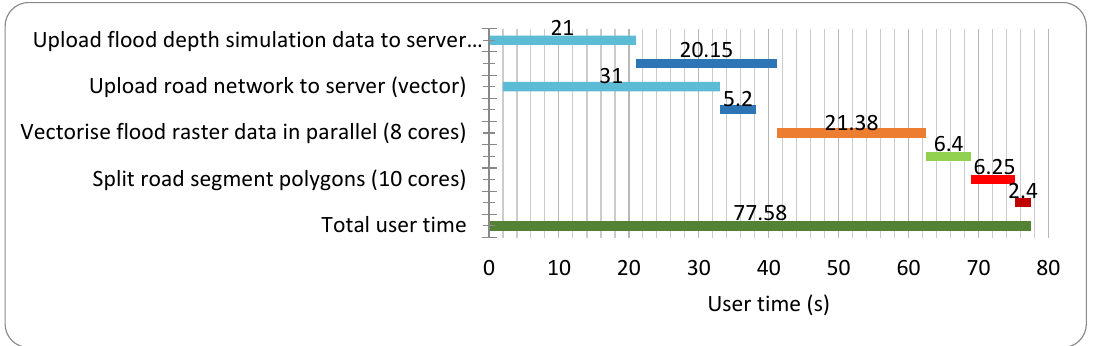
Figure 23. User time to calculate the economic impact for a road network in Ghent resulting from a fluvial flood event (return period 1000 years) using the FLIAT tool. The output of the FLIAT tool can be seen in Figure